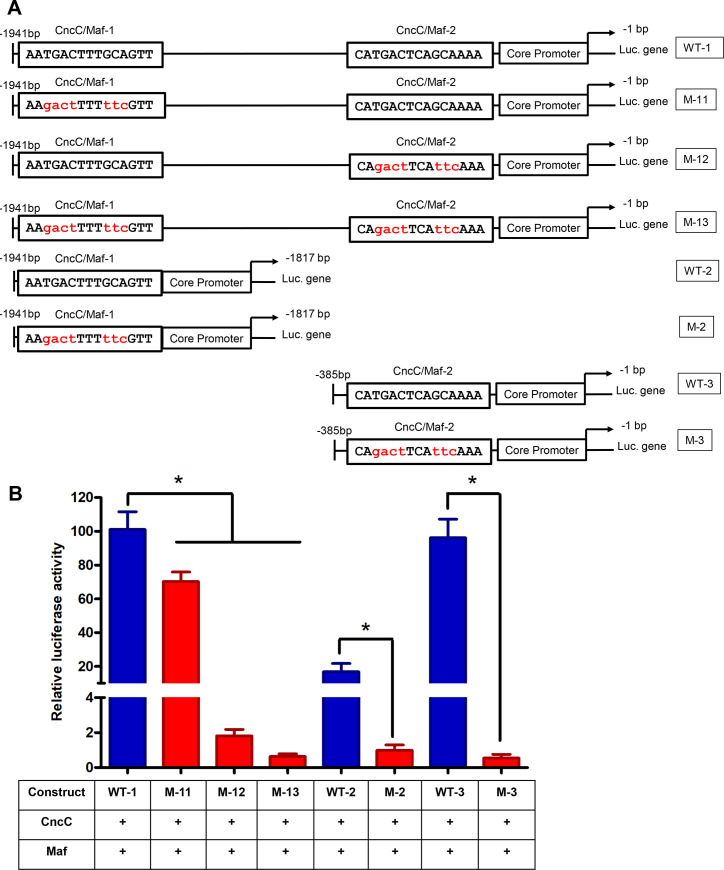
Mutations in CncC/Maf binding sites abolishes the ability of these transcription factors to induce the expression of CYP321A8.(A) Schematic representation of mutated CYP321A8 promoter constructs. (B) The activity of these constructs in reporter assays. Error bars indicate SD. The activity of each mutated construct was compared with the corresponding wild-type control by Student’s t-test and significant differences (p < 0.05) are indicated with an asterisk.